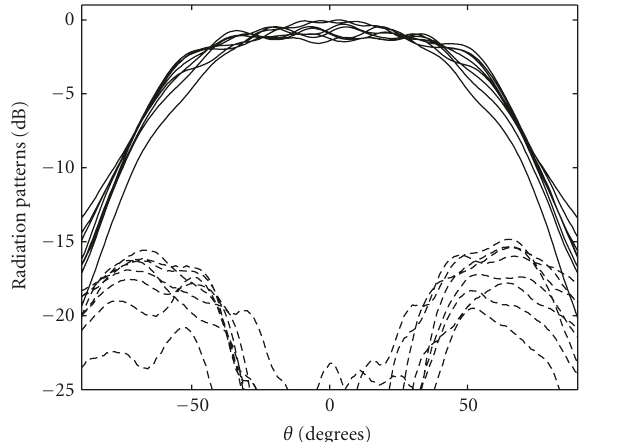
(a) Measured uncompensated radiation patterns for the array of Figure 7; { x − 45 ◦ measured , x +45 ◦ measured } T